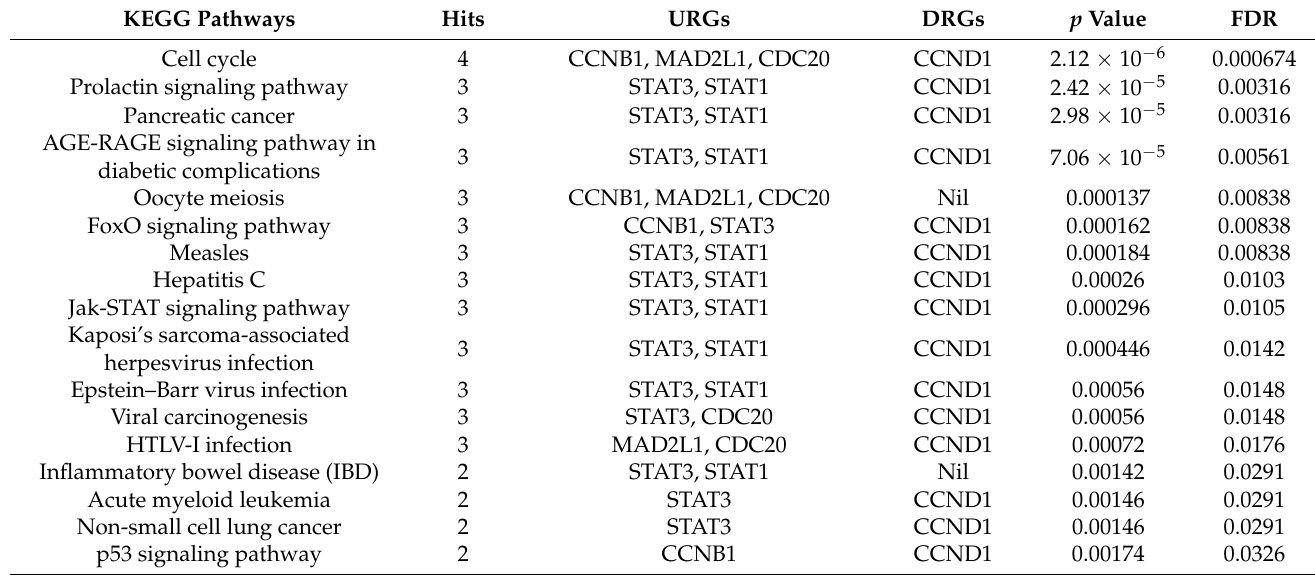
Table 4. Annotation of hub genes in KEGG.